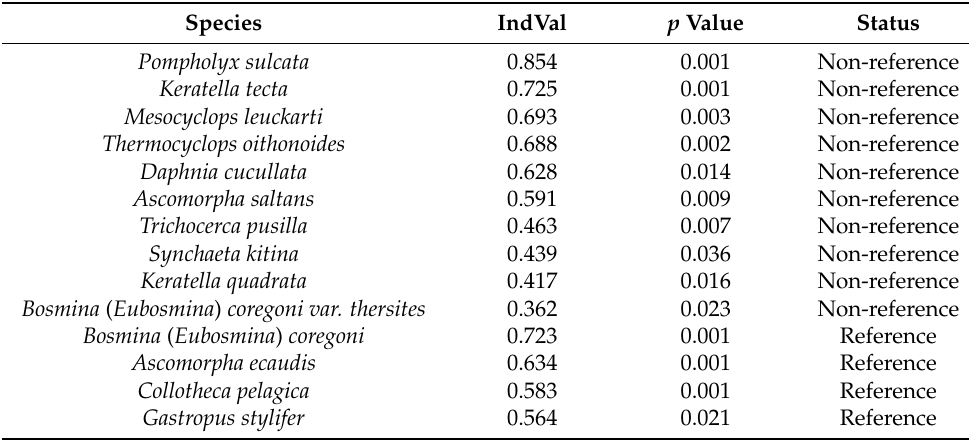
Table 3. Indicator Value (IndVal) of Crustacea and Rotifera species of the reference vs. non-reference conditions. Data from all samples (lake-years) were analyzed (n =